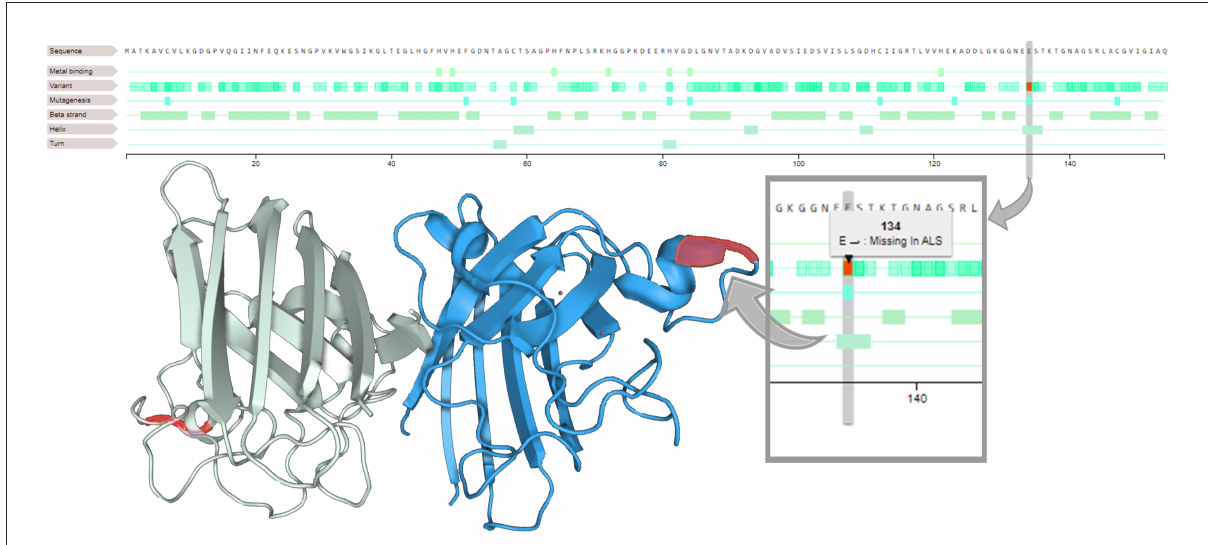
FIGURE3 Loss of glutamic acid in position 134 (on the right). On the SOD1 3D structure (on the left), residues 133–144 form an electrostatic ring in an alpha helix segment, a loop element that is critical in the binding function of the